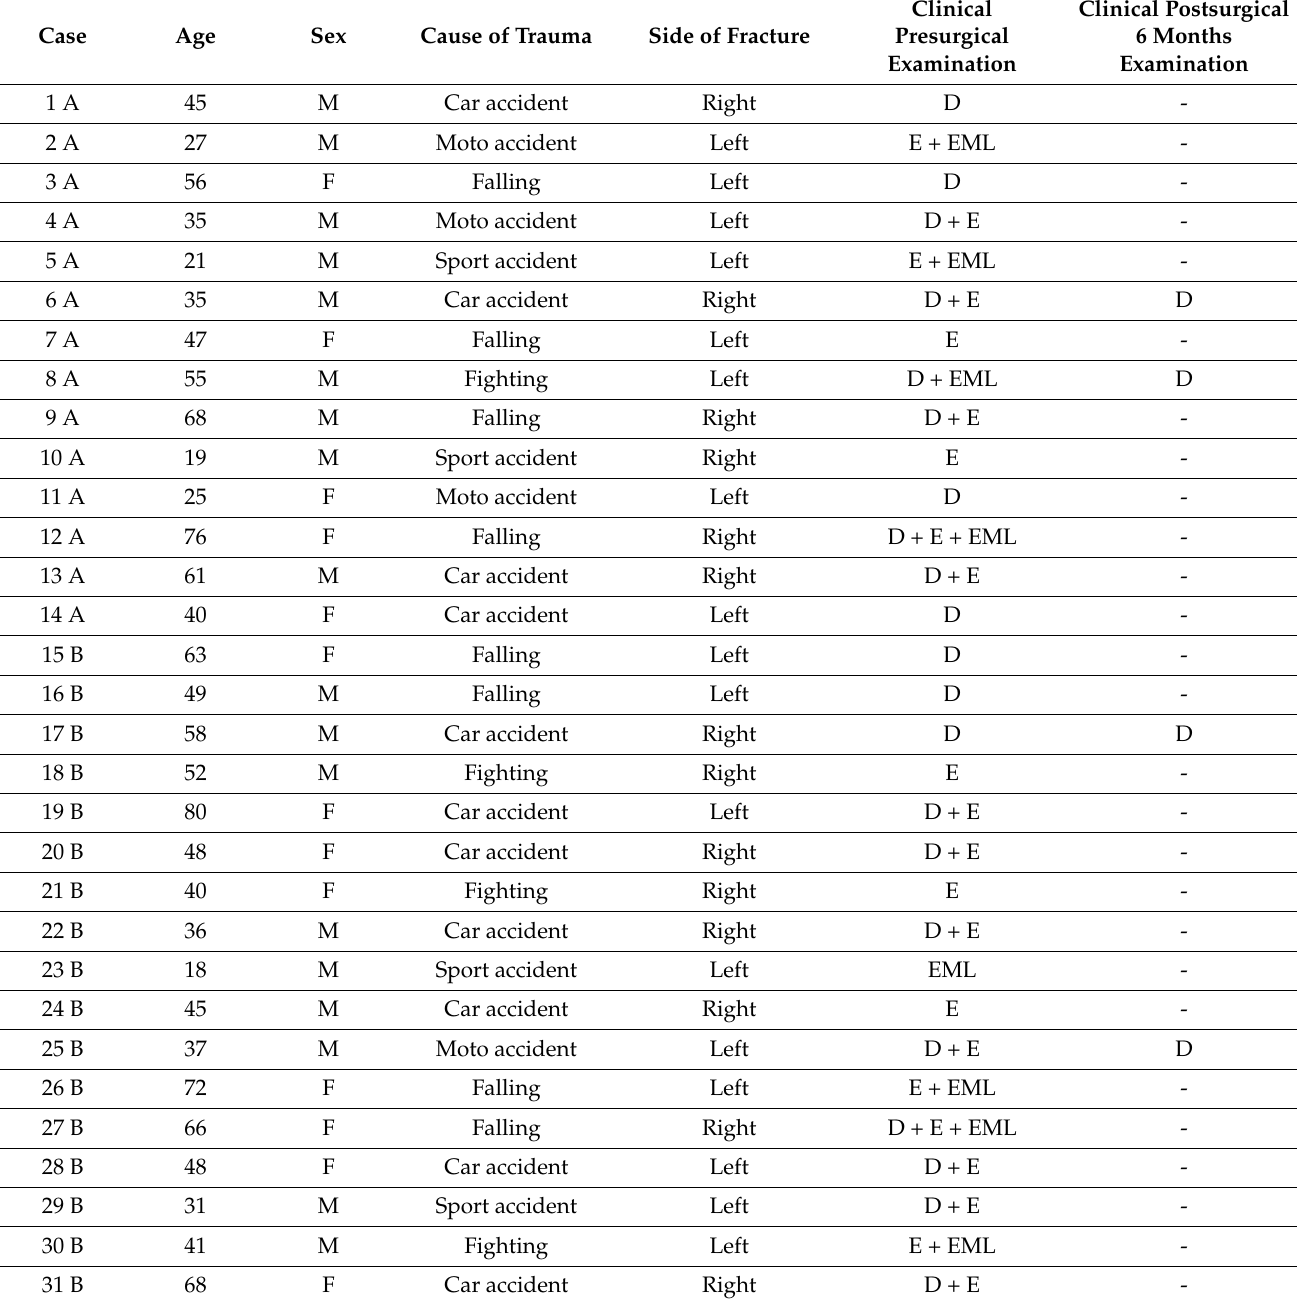
Table 1. Main features of 31 patients enrolled in the study. Legend: D: diplopia; E: